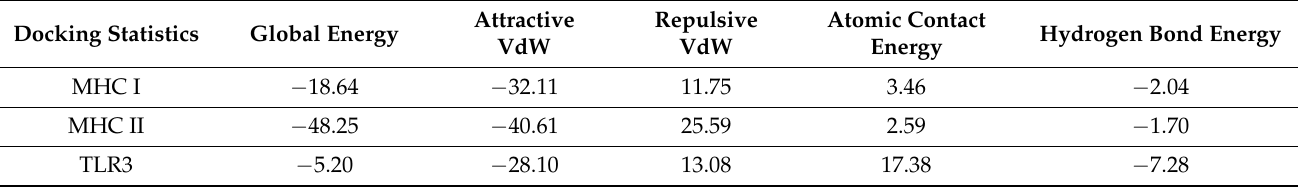
Table 4. Docking statistics of the designed vaccine construct to MHCI, MHCII, and TLR3 receptors, with energy given in kJ/mol.